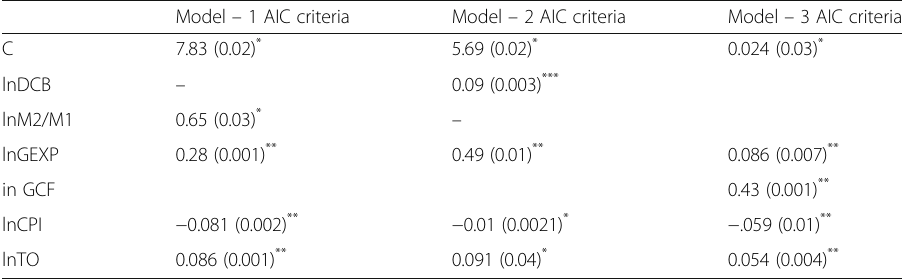
Table 6 Estimated Long-Run coefficient for the period 1980 – 2016 Model – 1 AIC criteria Model – 2 AIC